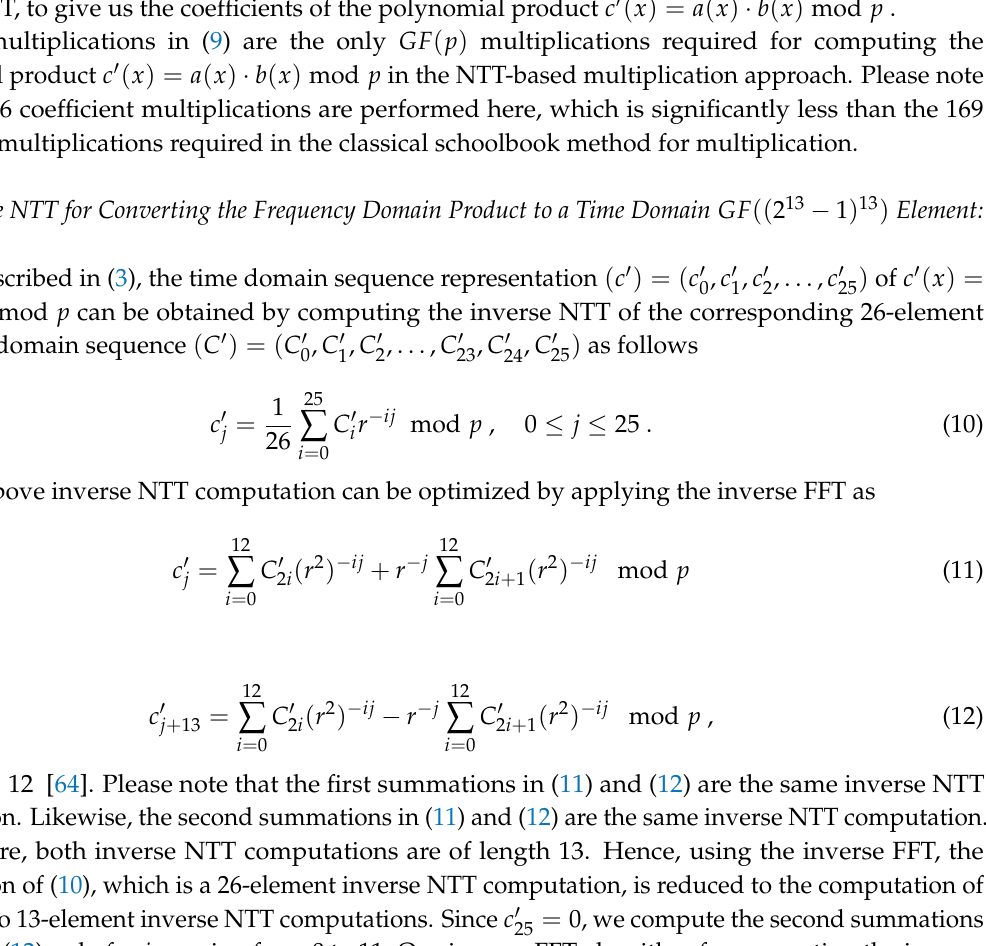
Algorithm 4. The following 26 pairwise coefficient multiplications generate the 26-element frequency domain sequence representation (C’) of the product c (cid:48) ( x ) = a ( x ) · b ( x ) mod p